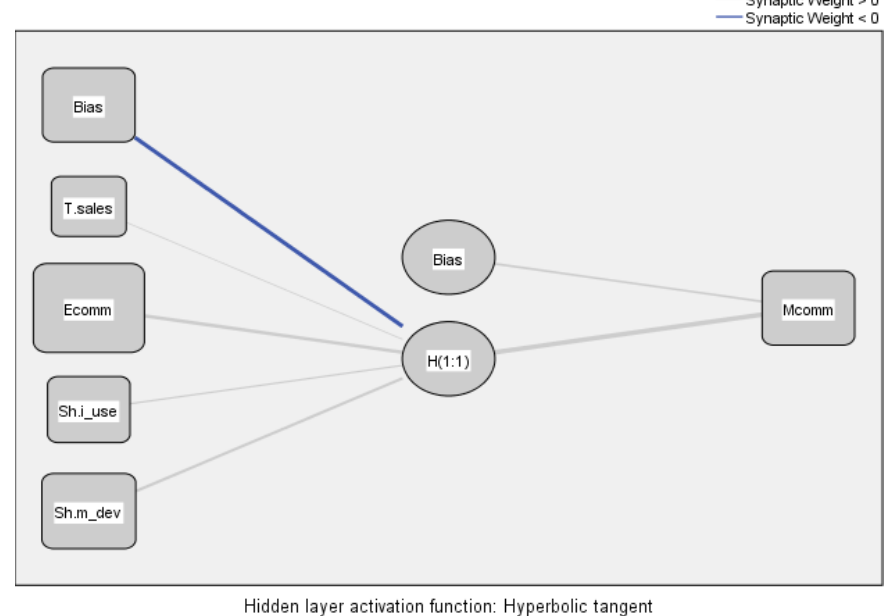
Figure 2. MLP model for identifying the influences on m-commerce. Source: developed using SPSS v.20. The error resulting from model testing is 0.023, while the error resulting from training is 0.164. The rescaling method used was data standardization. Table 4 shows the predictors of the MLP